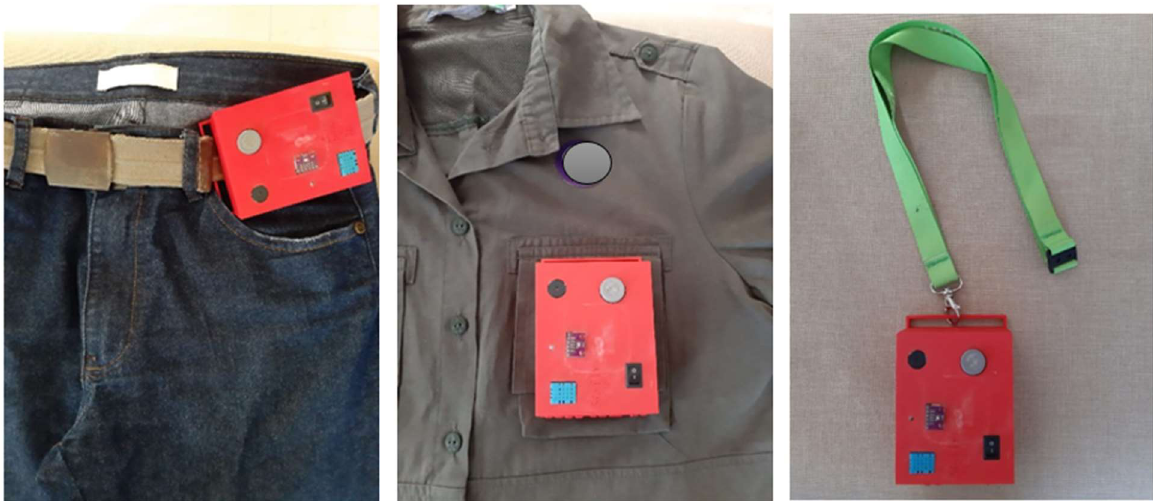
Figure 7. Fixing options for the wearable monitoring device prototype.